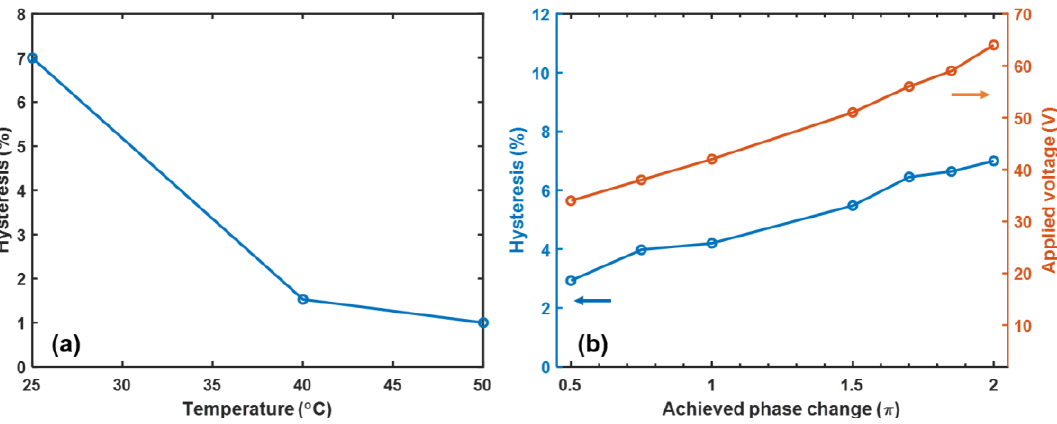
Figure 7. ( a ) Temperature dependent hysteresis of PNLC-4. ( b ) Hysteresis vs. applied voltage of